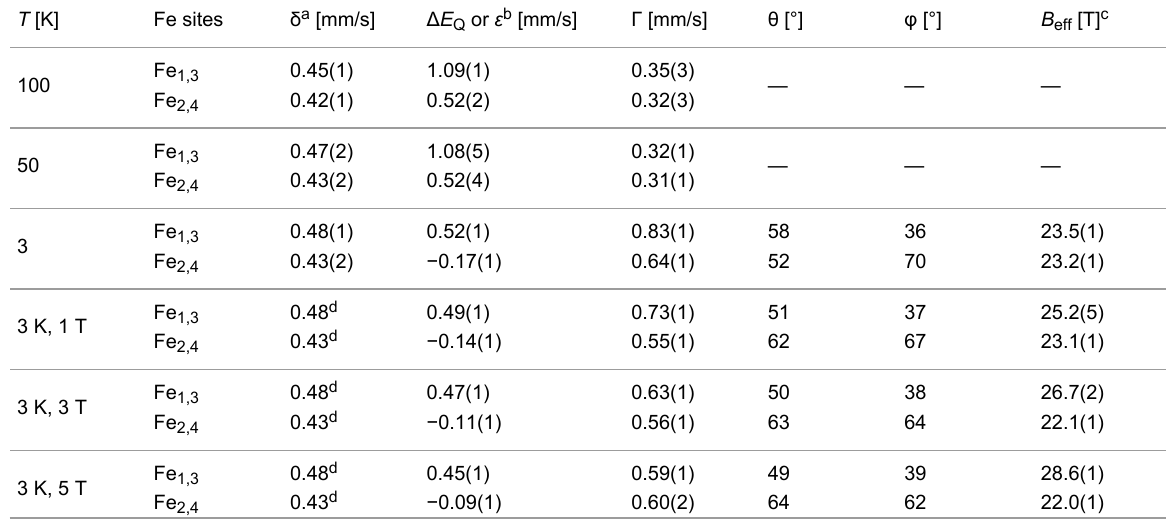
Table 1: Mössbauer data for [Fe 4 Dy 2 (OH) 2 ( N -nbdea) 4 ((CH 3 ) 3 CCOO) 6 (N 3 ) 2 ] ( 1